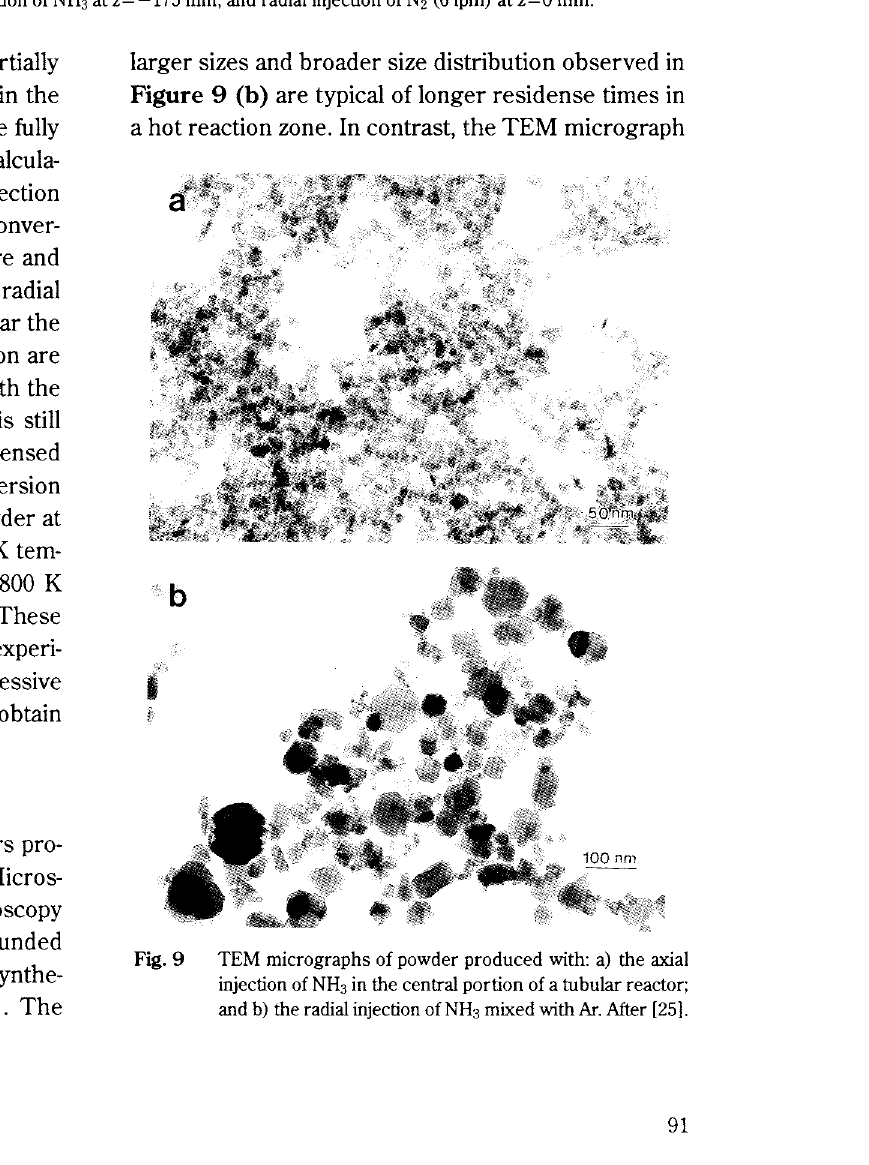
Fig. 9 TEM micrographs of powder produced with: a) the axial injection of NH 3 in the central portion of a tubular reactor; and b) the radial injection of NH 3 mixed with Ar. After